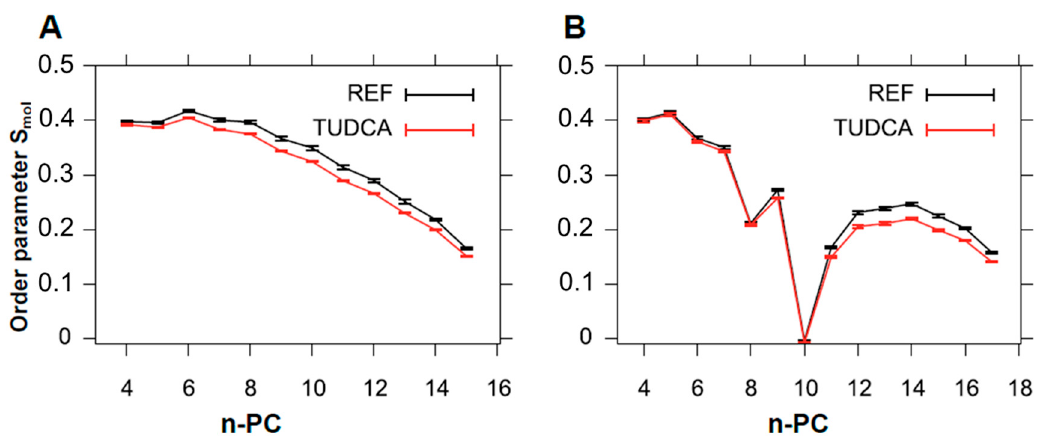
Figure 7. Order parameter of 5–, 7–, 10– and 16–PC in POPC/DMPE membranes containing 40 ( A ) or 5 ( B ) mol% cholesterol. Spectra were acquired at 310 K. Full symbols denote a control membrane and empty symbols—a membrane containing 5 mol % TUDCA.